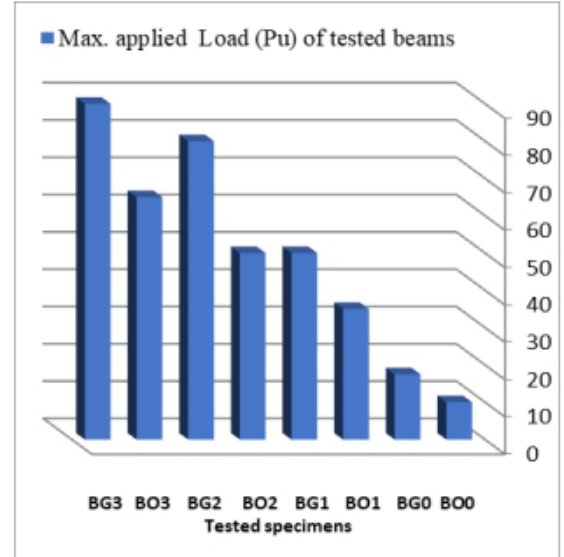
Fig. 8. Maximum Applied of Tested